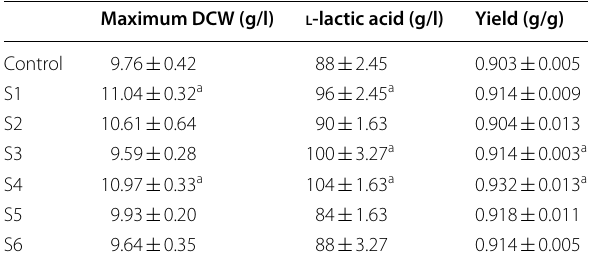
Table 1 Fermentation performances of parent strain, mutants S1 to S6 at 24 h with a 5-l